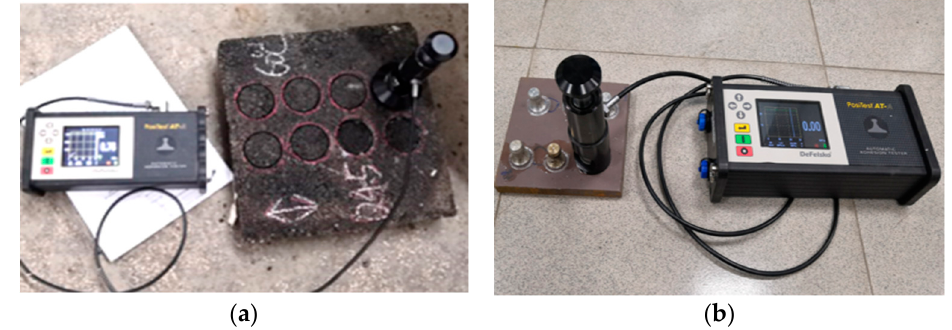
Figure 9. Pull-off test setups for ( a ) the with-zinc and no-zinc specimens and ( b ) the no-WBM and with-WBM specimens.